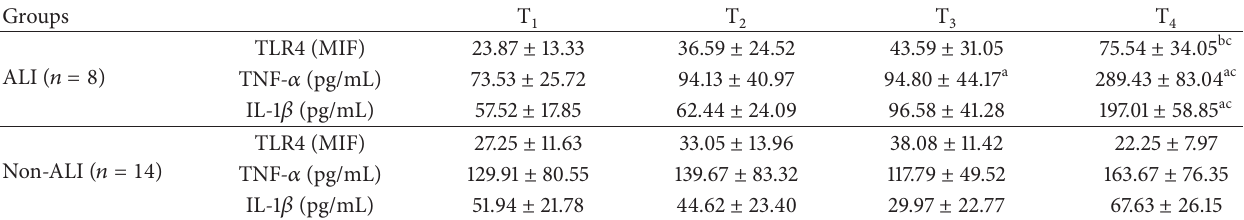
Table 2: Perioperative differences in the expression of TLR4 on PMNs and the serum concentrations of TNF- 𝛼 and IL-1 𝛽 between patient groups.